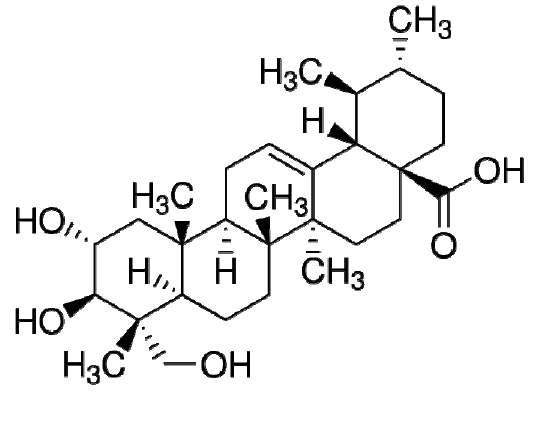
Figure 1. Chemical structure of asiatic acid (from